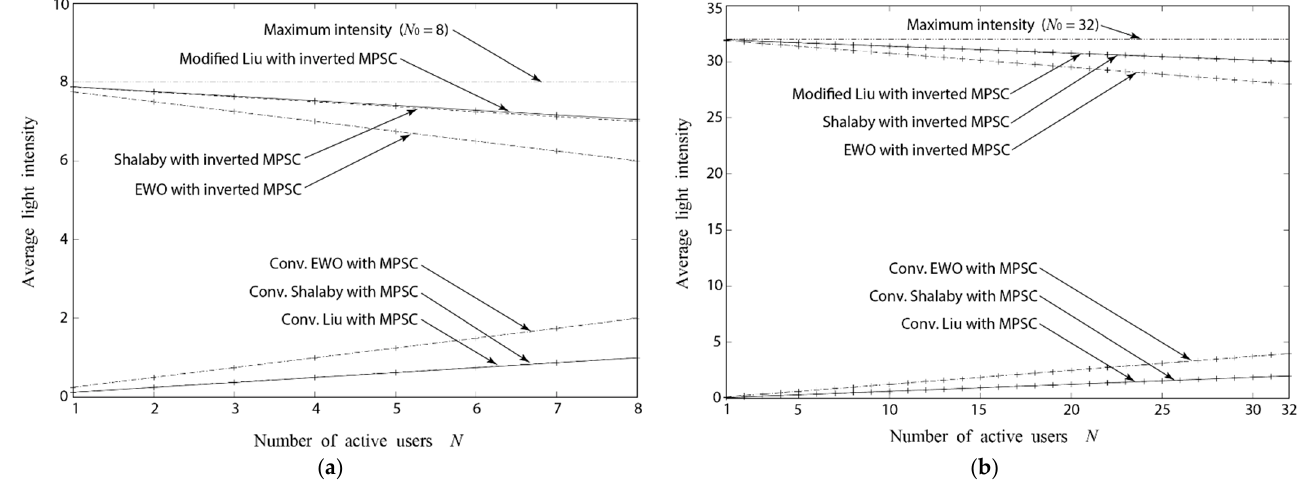
Figure 5. Comparisons of average light intensity. ( a ) q = 4, N L = 8, and 1 ≤ N ≤ 8, ( b ) q = 8, N L = 32, and 1 ≤ N ≤ 32.